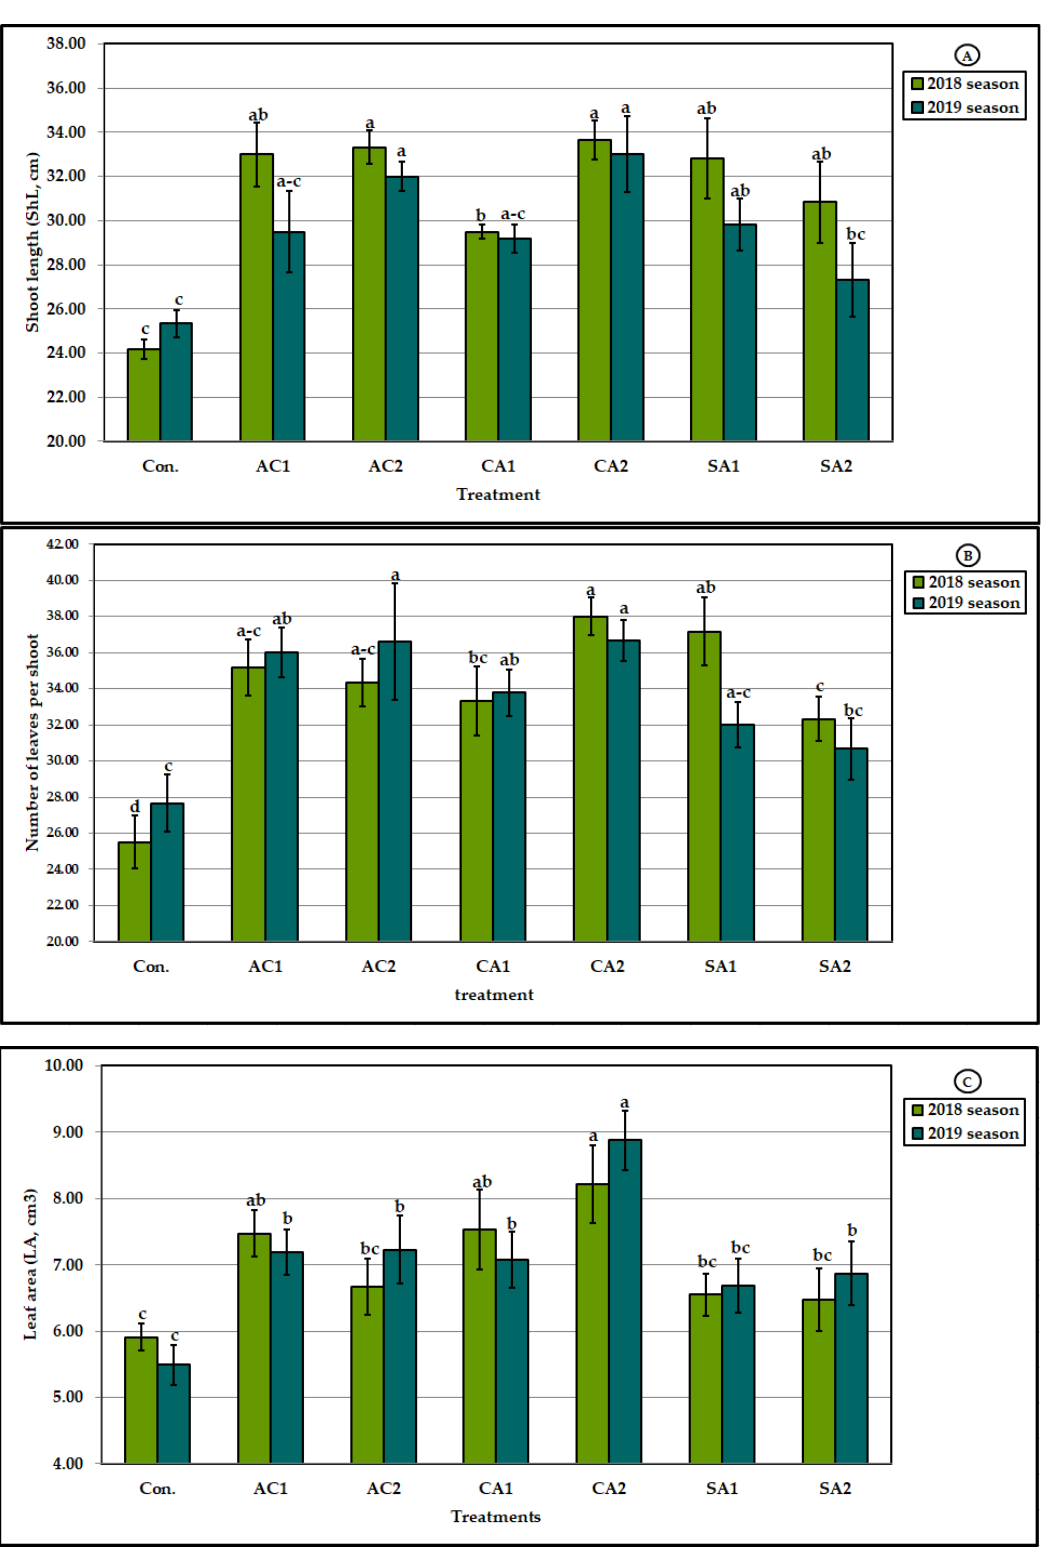
Figure 2. Effect of acidifying agents applied to ( A ) shoot length (ShL, cm); ( B ) number of leaves per shoot; and ( C ) leaf area (LA, cm 3 ) of olive trees picual cv. grown in a sandy loam clay soil under multi-abiotic stresses (pH = 7.78 vs. 7.89; CaCO 3 = 8.8 vs. 9.2%; and ECe = 6.4 vs. 7.2 dS m −1 and). Different letters in each column indicate significance at p ≤ 0.05. CA 1 , CA 2 , AC 1 , AC 2 , SA 1 , and SA 2 represent citric acid, acetic acid, and sulfuric acid applied at 25 and 50 cm 3 , respectively. The results (Figure 3A – C) showed that all applied acids markedly increased the studied physiological parameters, including SPAD chlorophyll, Fv/Fm, and the perfor- mance index (PI). The data obtained indicated that the AC 2 treatment was the superior treatment in both the 2018 and the 2019 seasons, with recorded values of 0.838 vs. 0.831 for fv/fm and 5.39 vs. 5.44 for PI and an increase in percentages of 3.08 vs. 2.72 and 42.21 vs. 39.85% when compared with the control treatment, which had the lowest values (0.813 vs. 0.809 for fv/fm and 4.17 vs. 3.89 for PI) in the 2018 and 2019 seasons, respec- tively. The plants treated with CA 2 had the highest values (82.45 vs. 82.52) for SPAD, while the lowest values (76.60 vs. 75.20) were produced in the untreated plants. The in- crease in percentages was 7.64 vs. 9.80% for the 2018 and 2019 seasons, respectively.